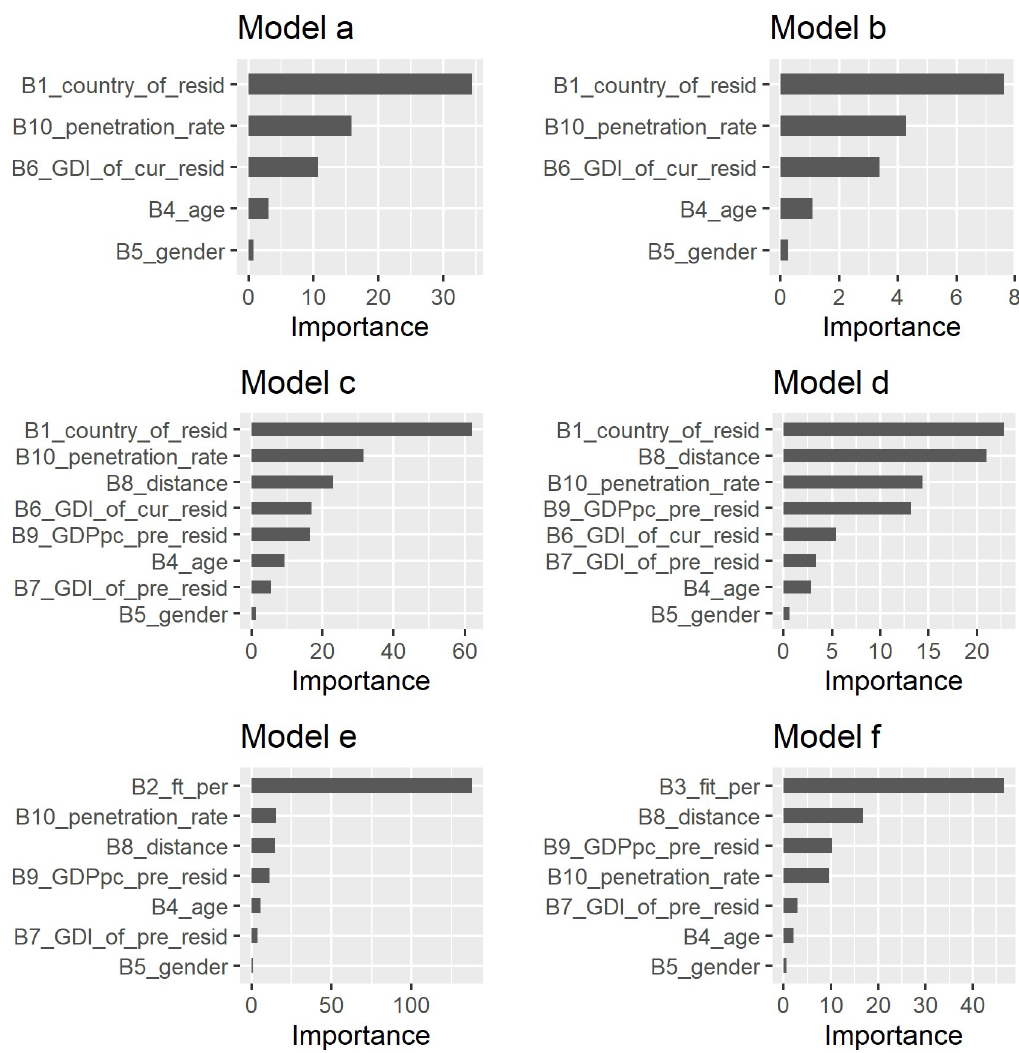
Fig 3. Variable importance for each independent variable using the Random Forest